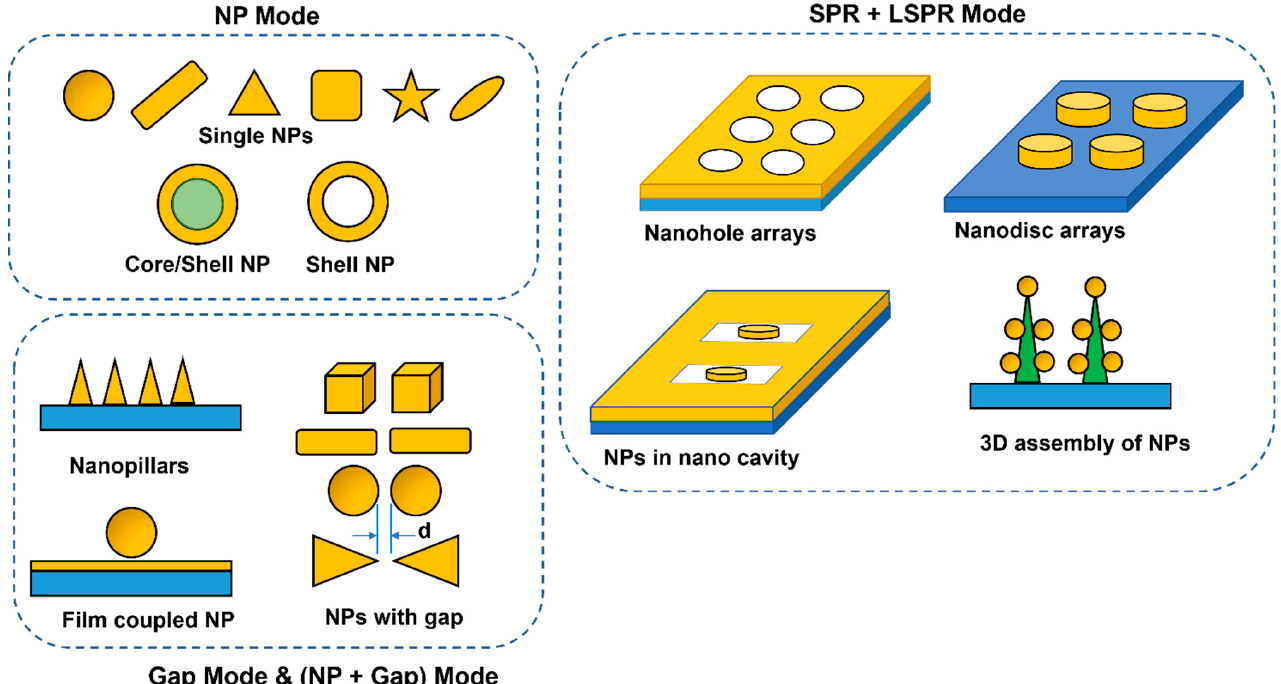
Figure 4. Schematic of nanoparticle (NP) images showing representative examples of localized surface plasmon resonance (LSPR or NP mode), gap mode, and combination of propagating surface plasmon resonance (SPR) and LSPR modes.